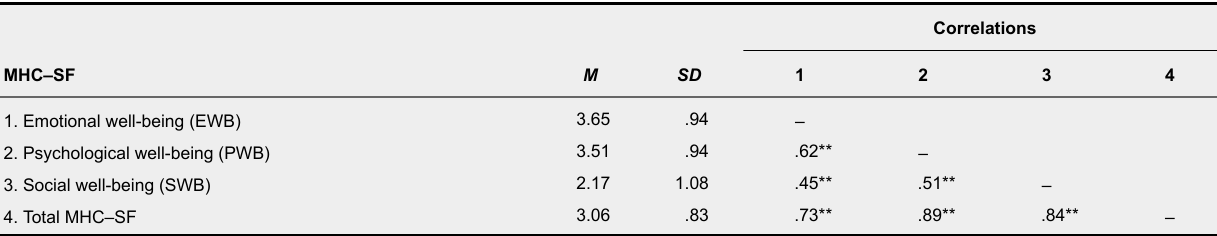
Descriptive Statistics and Correlations of the MHC–SF Subscales and Total MHC–SF Score